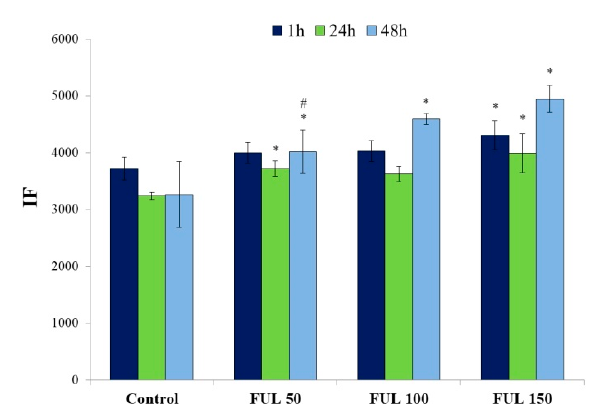
Figure 6. Quantitative measurements of fullerenol in PBMCs were carried out by flow cytometry in time-dependent mode (flow cytometer FACS, 355 nm laser); after 1 h, 24 h, and 48 h of incubation with NPs (37 °C, 5% CO 2 atmosphere, 100% relative humidity). Bars represent mean values with standard deviations. Asterisks are used to mark values that are statistically different in comparison with control values (* p < 0.05), hashes—values that are statistically different in comparison with samples containing fullerenol at the concentration of 150 mg/L ( # p < 0.05). All experiments were repeated 3–6 times.